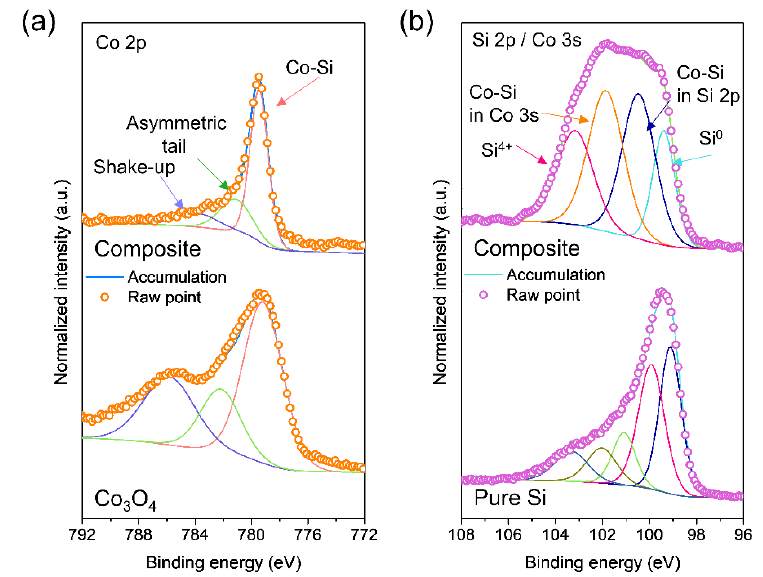
Figure 2. XPS core-level spectra of the composite: ( a ) Co 2p and ( b ) Si 2p/Co 3s.